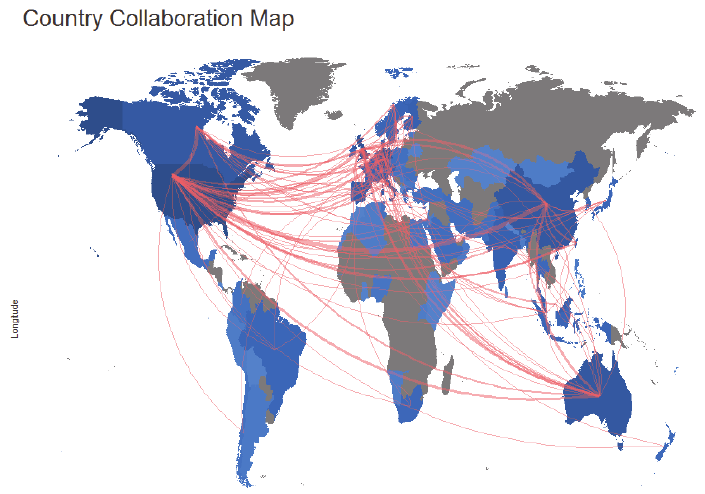
Fig. 8 . Country collaboration